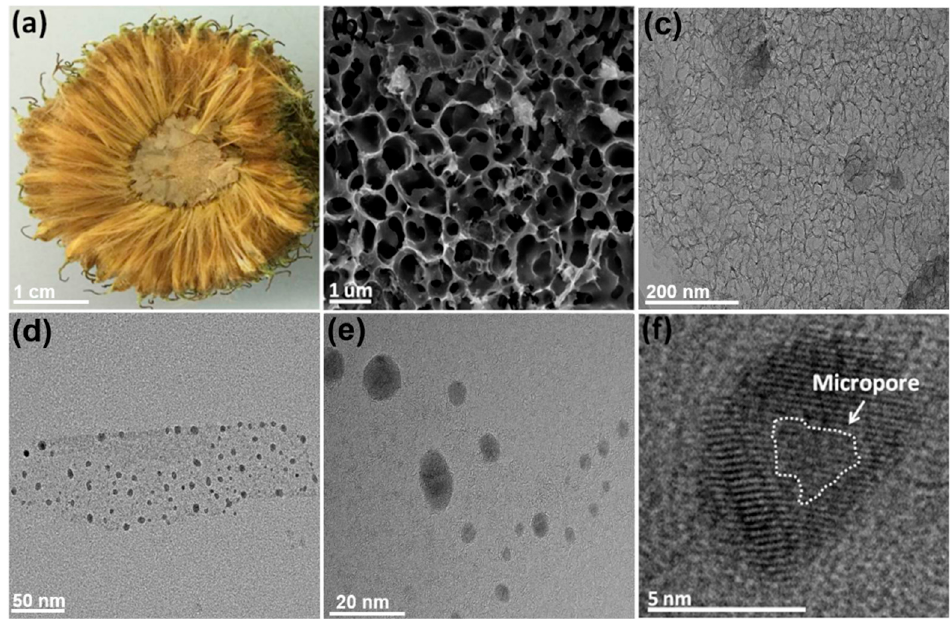
Figure 2. ( a ) Photograph of Platanus biomass. ( b , c ) SEM and TEM images of porous carbon (PC) after KOH activation. ( d – f ) TEM and high-resolution TEM (HR-TEM) images of NM-CQDs.